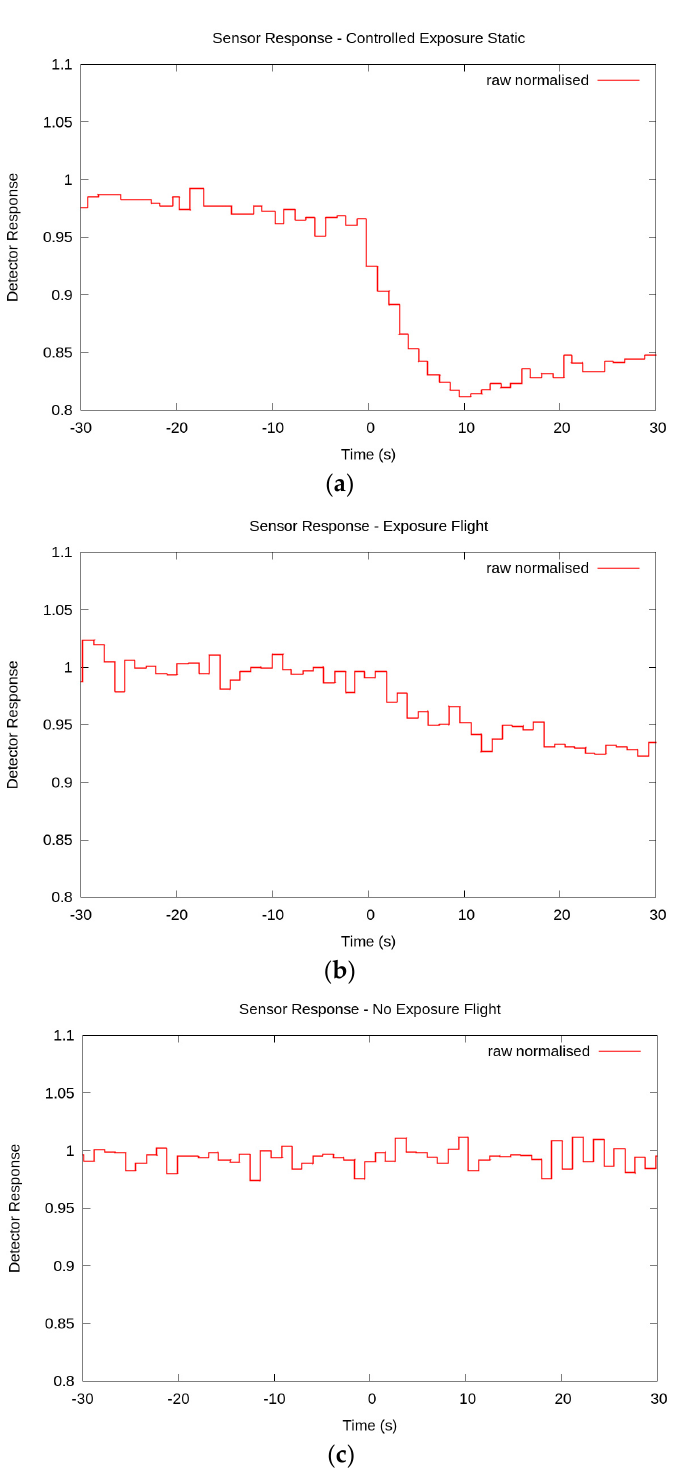
Figure 5. ( a ) On-board normalised chemical vapour detector response for SET; ( b ) EFT; ( c ) NEFT. Time axis t = 0 is the detection instant in the SET and EFT results.